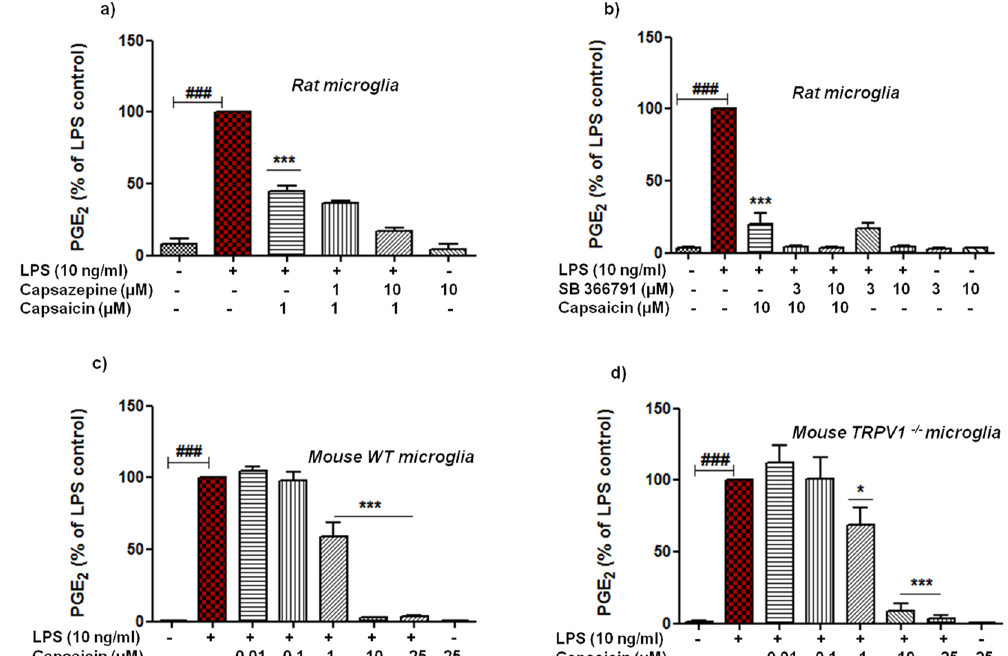
Figure 4. Effects of pharmacological inhibition and genetic deletion of TRPV1 in capsaicin (cap) treated activated microglia. Rat primary microglial cells were pre-treated either with capsazepine ( a ) or SB366791 ( b ) for 30 min thereafter cap was added for the next 30 min subsequently, cells were incubated with LPS (10 ng/ml) for 24 h. Mouse primary microglia were taken from either wild type (WT) animals ( c ) or from TRPV1 − / − animals ( d ). In both cases cells were pre-treated with cap (0.01–25 μ M) for 30 min thereafter incubated with LPS (10 ng/ml) for the next 24 h. At the end of incubation, cell supernatants were collected and release of PGE 2 was measured by EIA. Statistical analyses were carried out by using one way ANOVA with post hoc student Newman-Keuls test (Multiple comparisons). Results are expressed as means ± SE of three independent experiments. # p < 0.05; ## p < 0.01; ### p < 0.001 compared with control cells. * p < 0.05; ** p < 0.01; *** p < 0.001 compared with LPS (10 ng/ml) activated